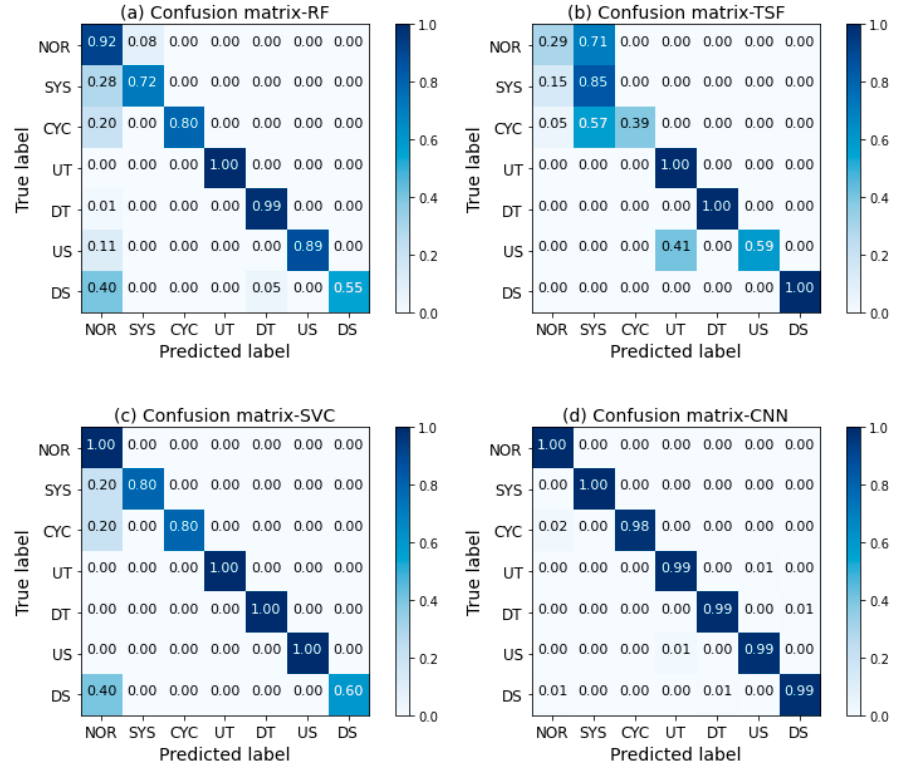
Figure 14. Confusion matrices obtained from experiment 1 (with data augmentation). Each row represents a true class, while each column represents a predicted class.